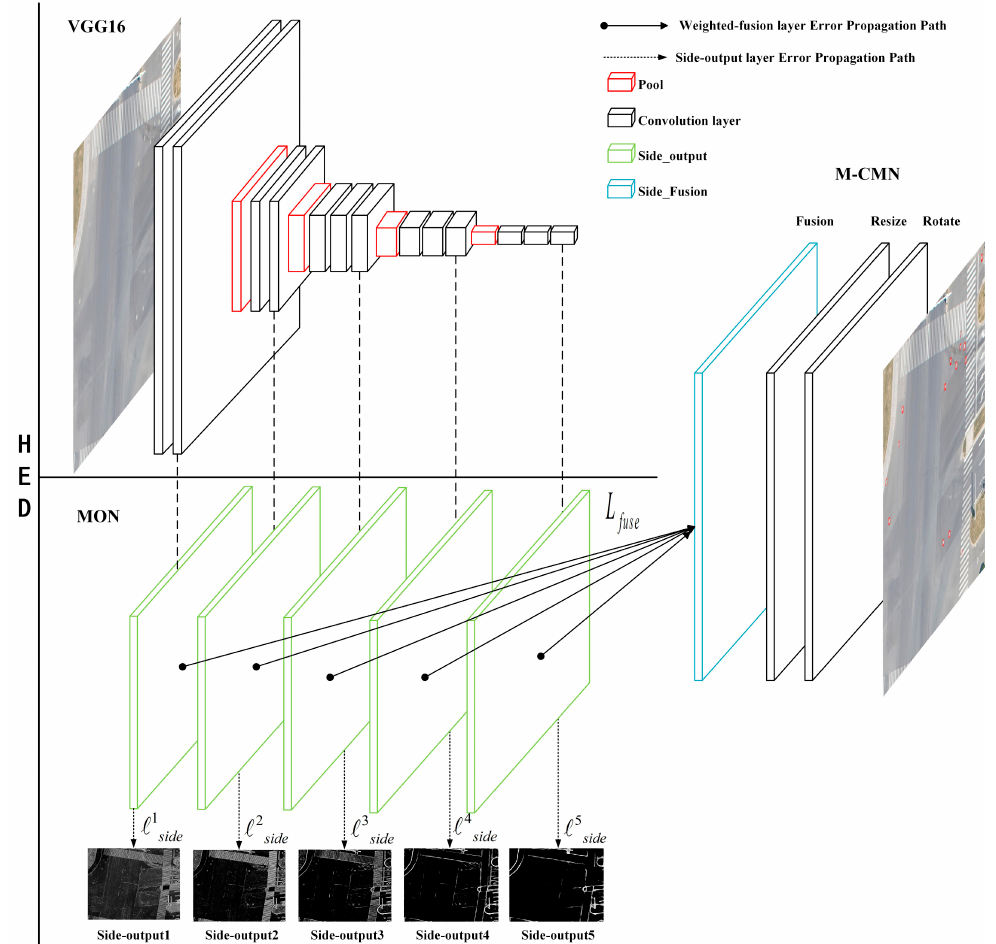
Figure 1. Architecture of our proposed method. Deep supervision is imposed at each side-output layer, guiding the side-outputs to obtain multi-level outputs. The subsequent fusion layer aids in learning how to combine outputs from multiple scales.